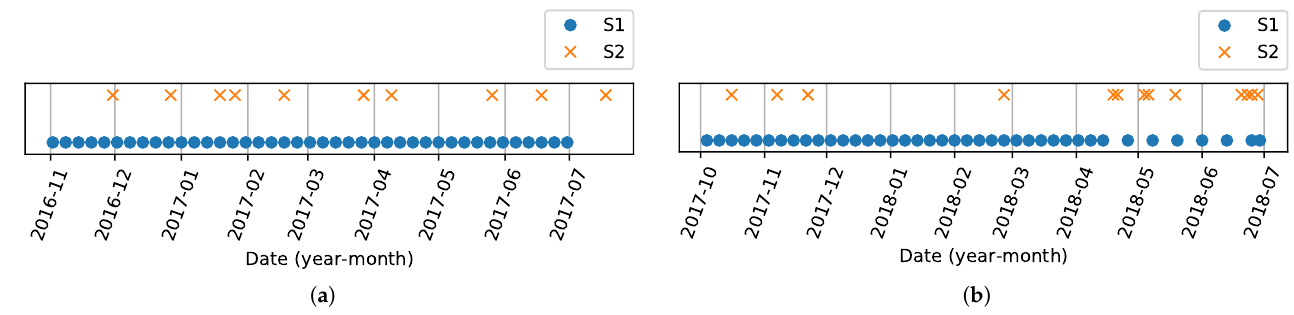
Figure 2. Each marker corresponds to the acquisition date of a used image for the growing season ( a ) 2016/2017 and ( b )